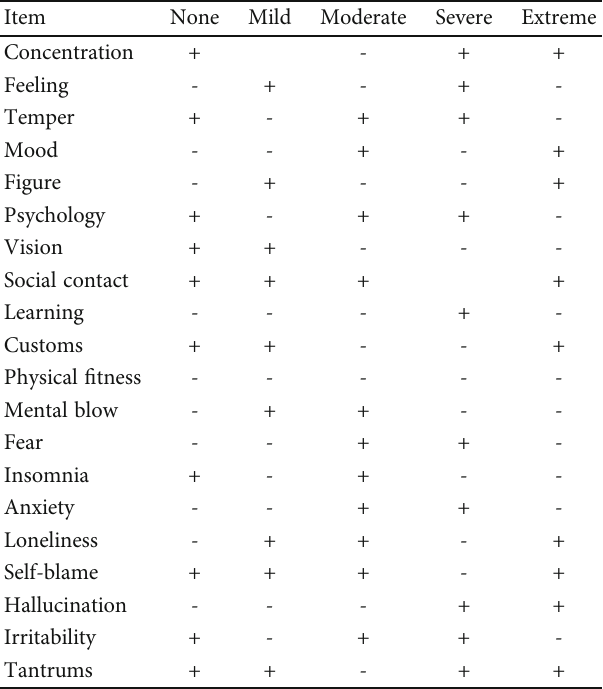
Table 3: Factors a ff ecting the physical exercise and psychological changes of college students before and after the